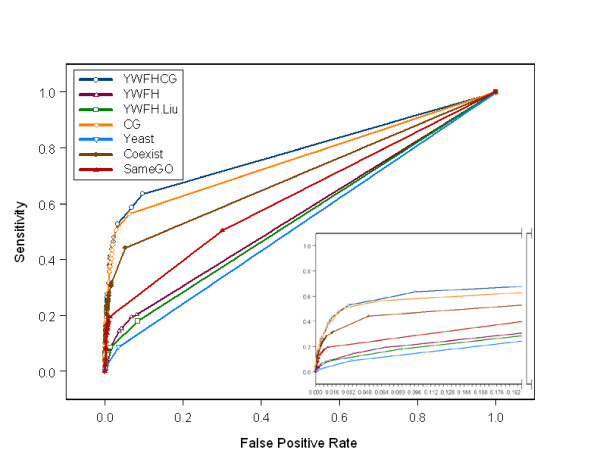
The relationship between false positive rate and sensitivity for predicting domain interactions using the Bayesian method with different data sources. The letters Y, W, F, H, C, and G indicate domain interactions based on yeast, worm, fruitfly, humans, co-existence, and same GO function, respectively. YWFH.Liu shows the result of predicted domain interactions using the extended MLE method defined in Liu et al. [14] with protein interactions of yeast, worm, fruitfly, and humans.